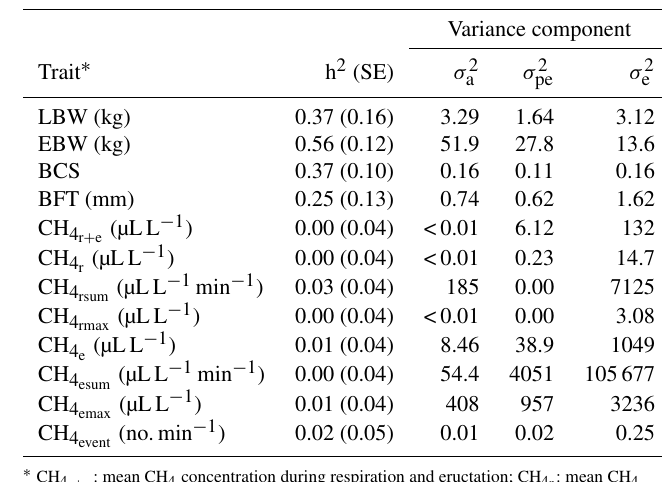
Table 3. Heritabilities (h 2 ) with standard errors (SE), additive genetic variances ( σ 2 a ), permanent environmental variances ( σ 2 pe ) and residual variances ( σ 2 e ) for lamb body weight (LBW), ewe body weight (EBW), ewe body condition score (BCS), ewe backfat thickness (BFT) and CH 4 traits.